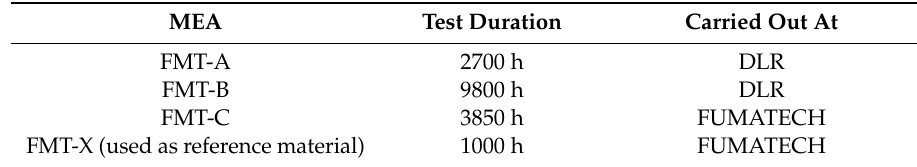
Table 1. Overview of the tested MEAs, tested at Deutsches Zentrum für Luft- und Raumfahrt (DLR; German Aerospace Center) and Fumatech BWT GmbH (FMT). MEA Test Duration Carried Out At FMT-A 2700 h DLR FMT-B 9800 h DLR FMT-C 3850 h FUMATECH FMT-X (used as reference material) 1000 h